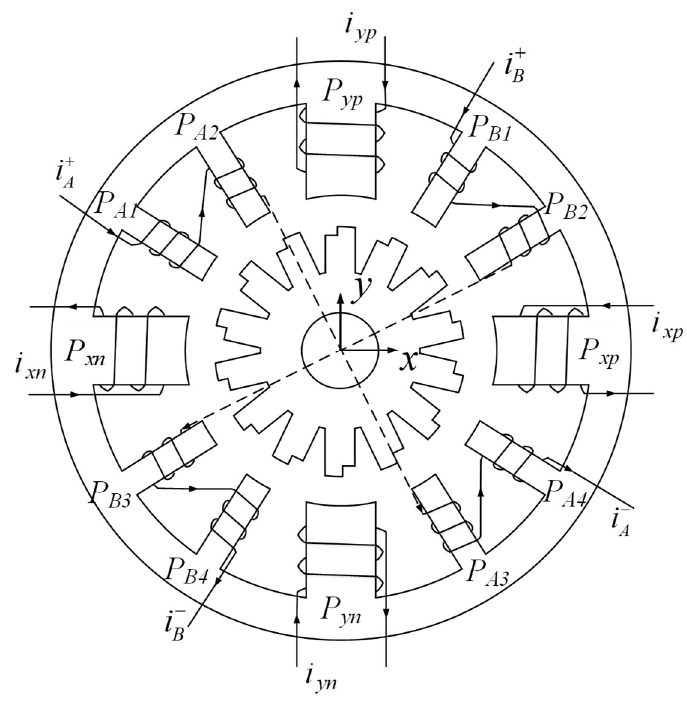
Figure 2. Structure of the stepped rotor BLSRM.